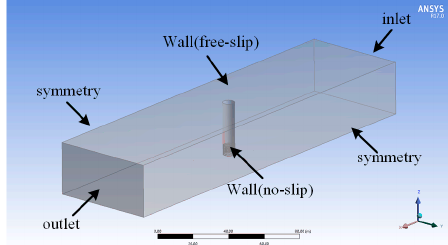
Figure 7. Boundary conditions. Figure 7. Boundary